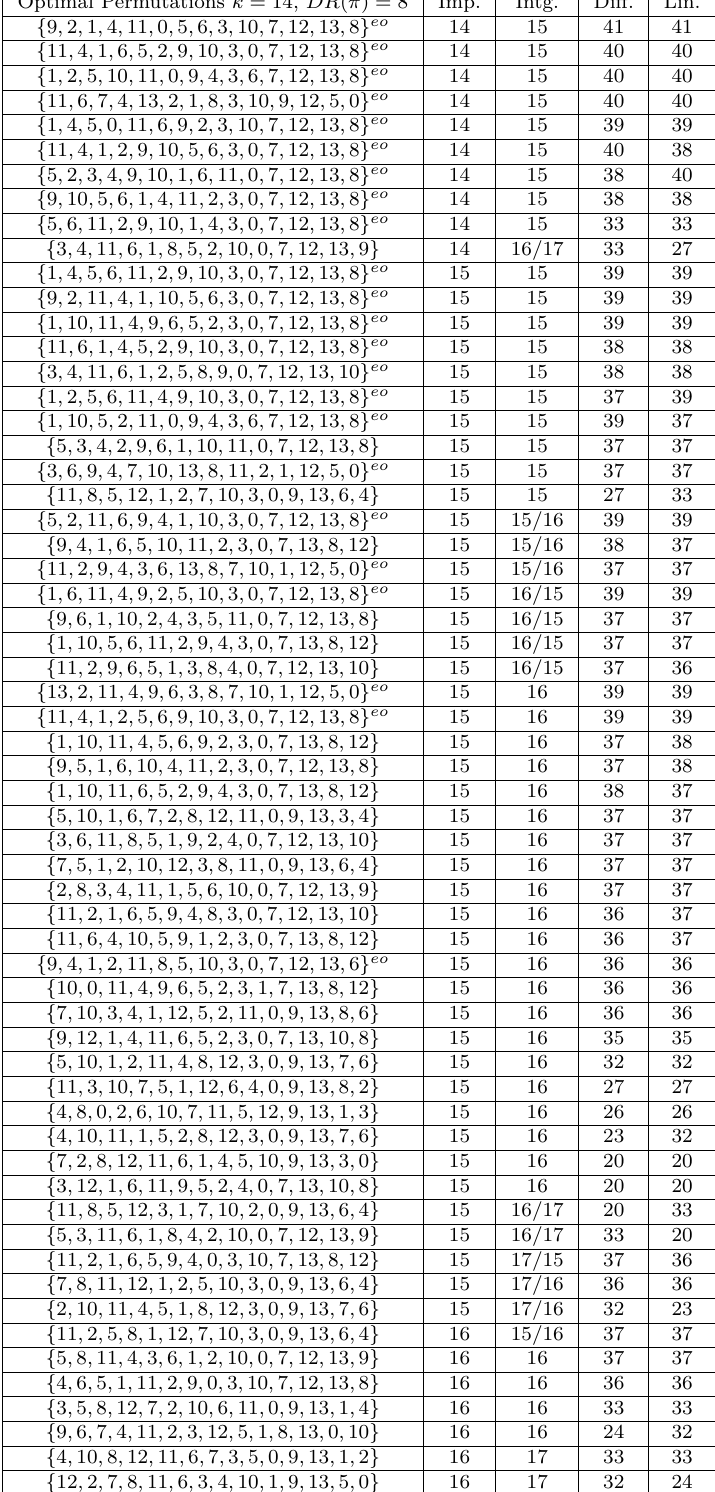
Table 15: Optimal permutations for k = 14 up to extended pair-equivalence Optimal Permutations k = 14, DR ( π ) = 8